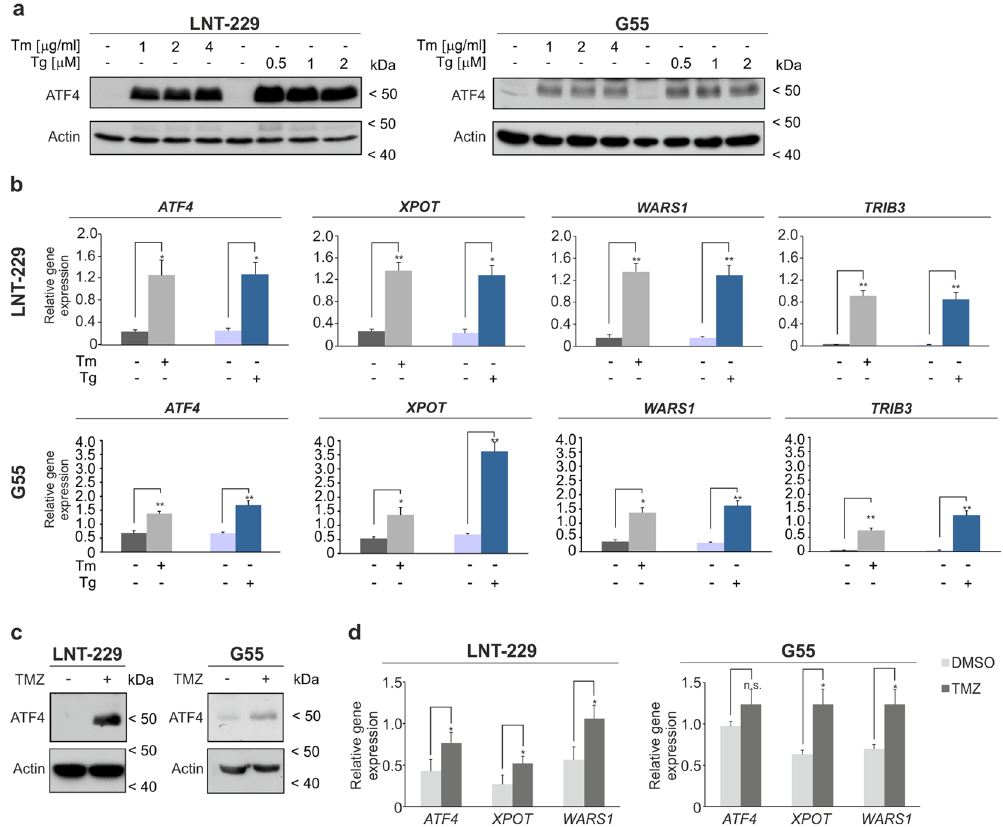
Figure 1. ATF4 is regulated by pharmacological ER stress activators and is induced by TMZ treatment in human glioblastoma cells. ( a ) LNT-229 and G55 cells were incubated with increasing concentration of thapsigargin (Tg) and tunicamycin (Tm) in serum-free DMEM for 8 h. Cellular lysates were analyzed by immunoblot with antibodies for ATF4 and actin. ( b ) LNT-229 and G55 cells were treated with 2 µg/ ml tunicamycin (Tm) or 1 µM thapsigargin (Tg) for 8 h in serum-free DMEM. cDNA was analyzed for the expression of ATF4 and its target genes XPOT , WARS1 and TRIB3 by qPCR. 18S and SDHA were used as housekeeping genes for normalization (n = 3, mean ± SD, *p < 0.05, **p < 0.01, Student’s t test). ( c ) LNT-229 and G55 cells were treated with 400 μM temozolomide (TMZ) in serum-free DMEM for 24 h. Cellular lysates were analyzed by immunoblot with antibodies for ATF4 and actin. ( d ) cDNA was analyzed for induction of ATF4 and target genes XPOT and WARS1 by qPCR (n = 3, mean ± SD, n.s. not significant, *p < 0.05, Student’s t test). SDHA and 18S were used as housekeeping genes for